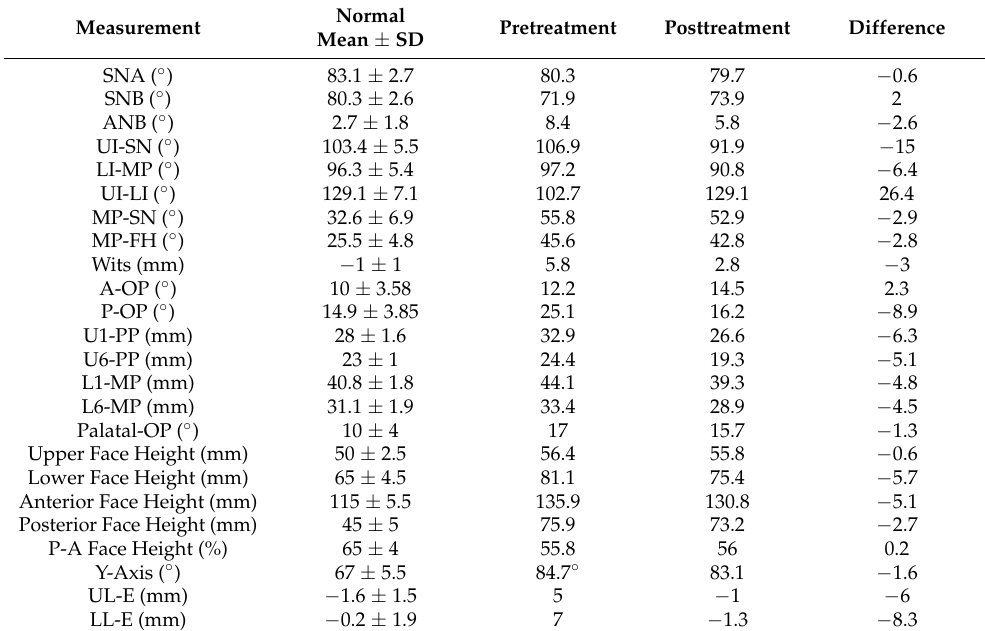
Figure 3. Pretreatment radiographs and tracing: ( A ) cephalometric radiograph; ( B ) cephalometric tracing; ( C ) panoramic radiograph. Table 1. Cephalometric